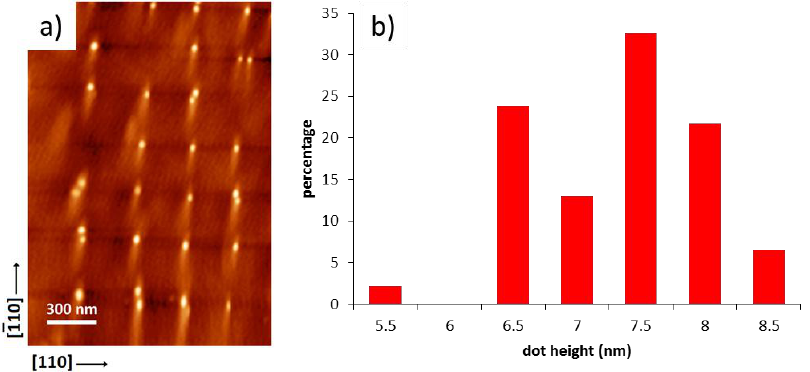
Figure 8. ( a ) AFM image of a tenfold stack of site-controlled InAs QDs grown on In-deoxidized hole arrays; ( b ) histogram of the height distribution relative to single dot-per-hole only.